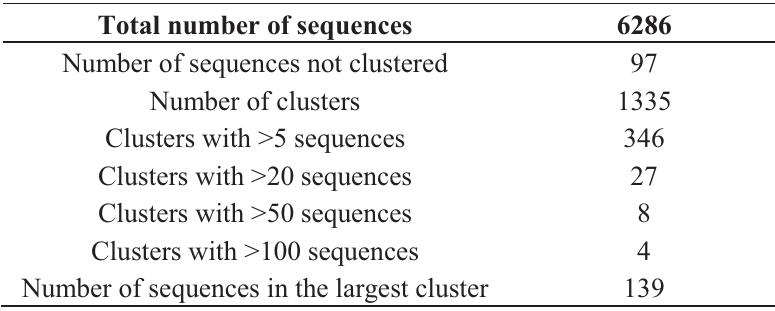
Table 2. Blastclust (L = 0.51 S = 80) based clustering analysis of the “ Novel ” Sunflower repeats that did not show any significant hits to the previously annotated repeats or to the TIGR all plant repeat